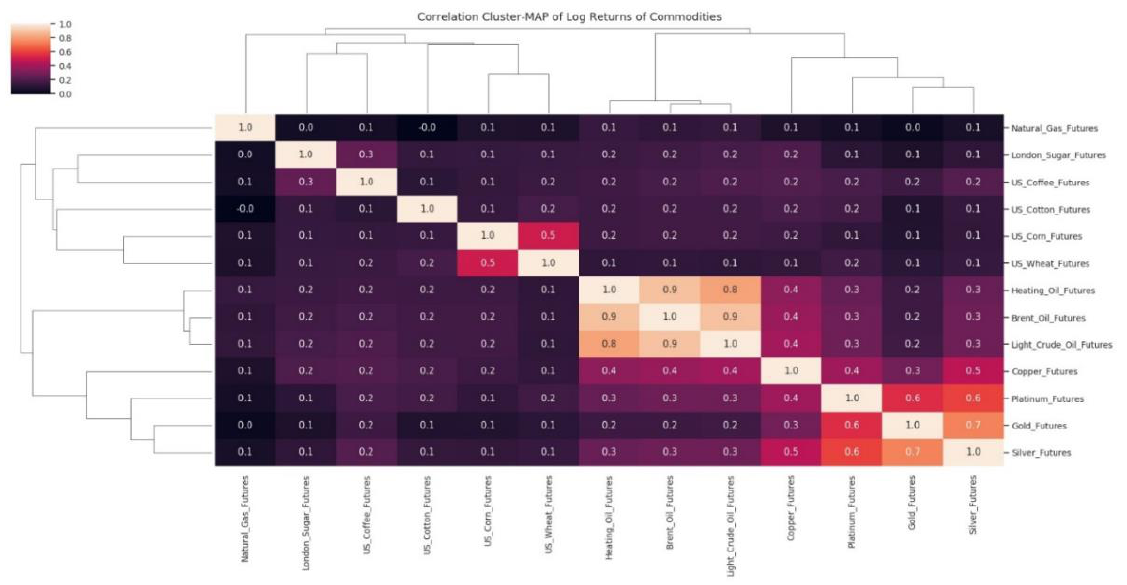
Figure 2: Correlation cluster map of daily energy, soft and hard commodity futures returns, observation period 2012-2018.